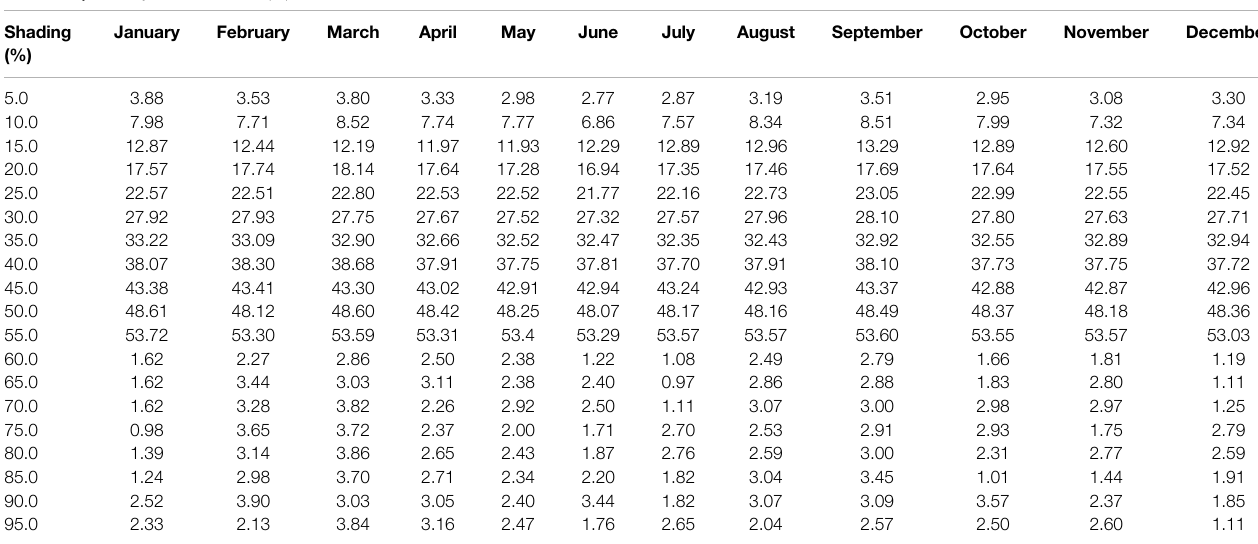
TABLE 9 | Monthly current losses (%). Shading (%)